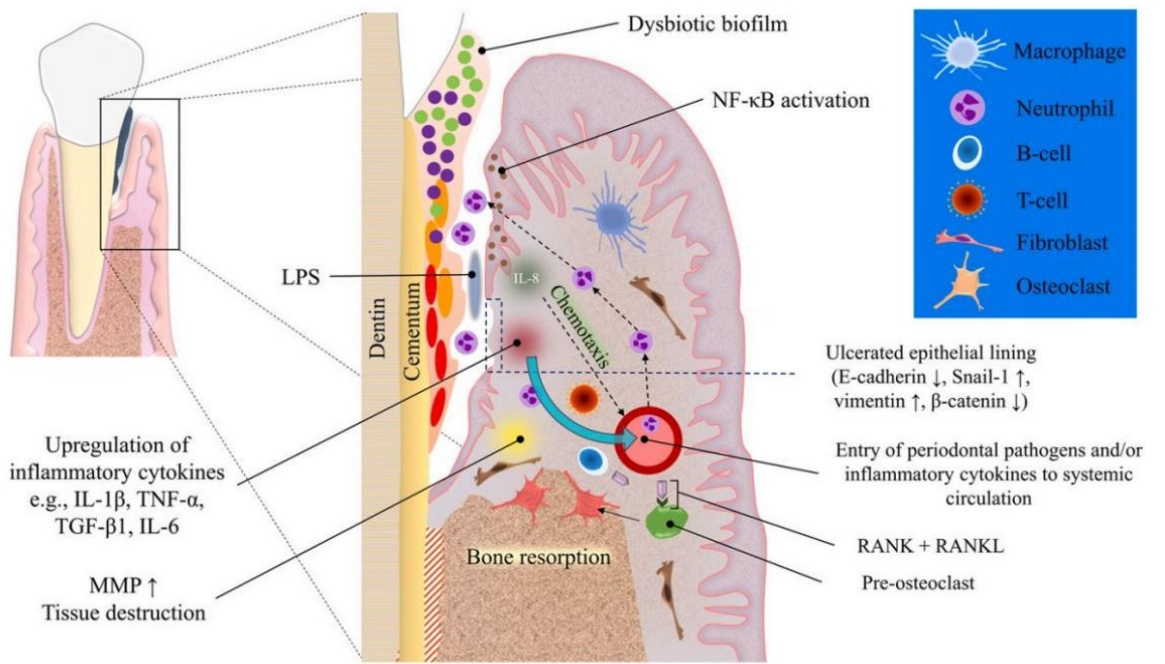
Figure 1. Schematic diagram of the pathogenesis of periodontitis. Dysbiosis of subgingival microbiome results in an increased populations of red and orange bacteria such as Porphyromonas gingivalis and Fusobacterium nucleatum. The virulence factors trigger an inflammatory response mainly via Toll-like receptor signaling which activates intracellular NF- κ B which in turn increases interleukin (IL) production. IL-8, in particular, acts as a chemotactic agent for inflammatory cells such as neutrophils and macrophages, recruiting them from nearby blood vessels. Cellular (T-cells) and humoral (B-cells) immune cells also increase in numbers due to the chemotactic gradients generated in association with chronic inflammation. These inflammatory events lead to further escalation of inflammatory mediator production. The tissue destruction and bone resorption increase due to overexpression of matrix metalloproteinases and RANKL, respectively. Reprinted/adapted with permission from Ref. [11]. 2022, Saliem, S.S.